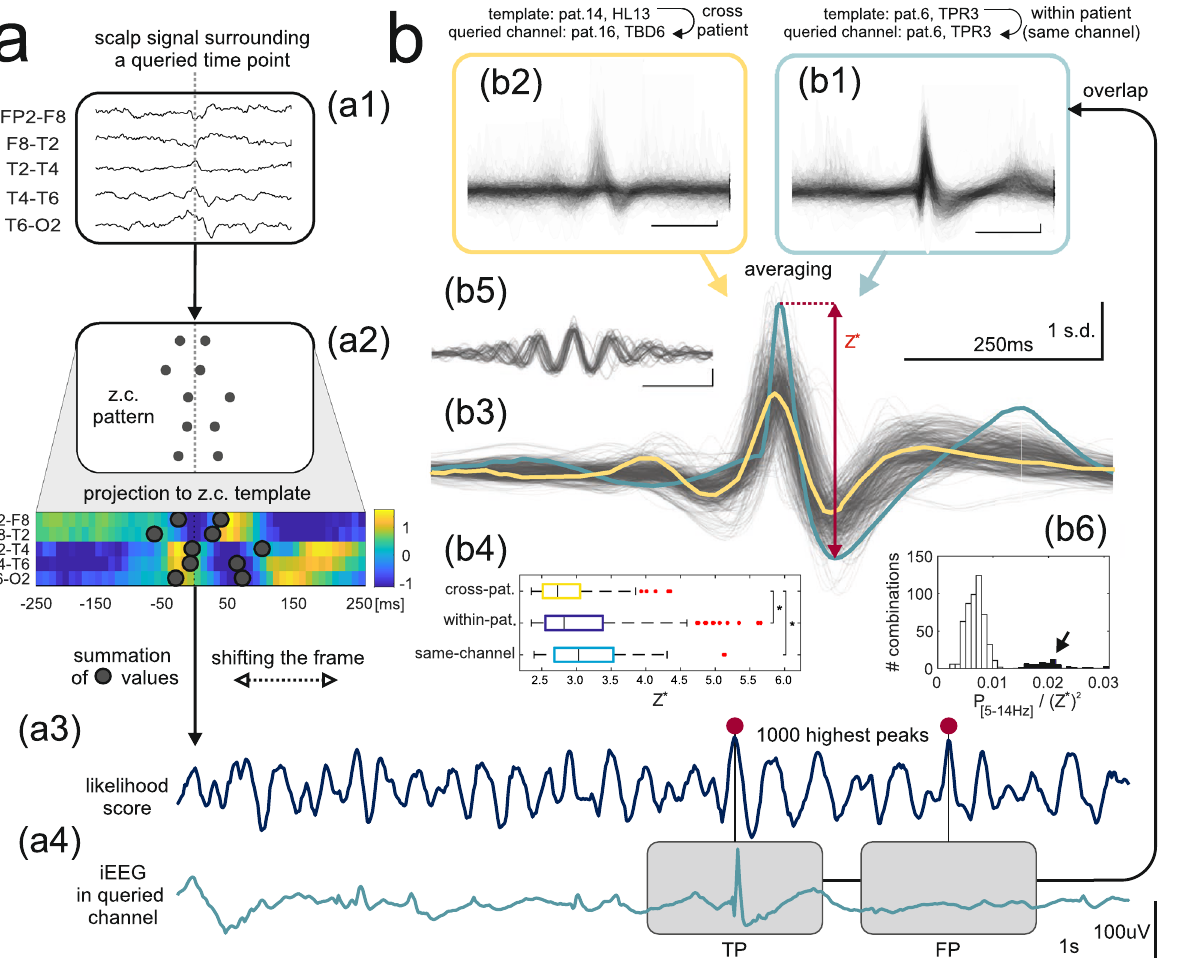
Figure 3. Detection of intracranial IEDs from scalp EEG. ( a ) Application of a template for intracranial IED detection basing on scalp EEG data alone. ( a1 , a2 ) Transformation of an unknown scalp signal ( a1 ) centered around a queried time point (dotted gray line) into a zero-crossing pattern with subsequent ‘projection” of the pattern onto the template ( a2 ) and summation of template values over zero-crossing coordinates to obtain the likelihood score. ( a3 ) Shifting the frame renders the likelihood score a function of time whose peaks are then used as the times of putative intracranial IEDs. ( a4 ) True positive (TP) and false positive (FP) detections are illustrated after referring back to a queried iEEG channel. ( b ) Single-trial detection and iEEG signal averaging. ( b1 , b2 ) Individual iEEG waveforms detected in two template-queried channel combinations show a high degree of overlap. ( b3 ) Consistent spike-like shapes after averaging of the individual waveforms for a subset of combinations (see “Results”). Light blue and yellow correspond to averages of ( b1 , b2 ), respectively. The peak-to- peak amplitude (Z * ) is illustrated as a measure of detection precision. ( b4 ) Comparison of Z * for within-patient, cross-patient, and same channel template-queried channel combinations. ( b5 , b6 ) Detection of theta and alpha rhythms (see “Results”): ( b5 ) Overlap of averaged waveforms. ( b6 ) Clustering of the averaged waveforms, the arrow indicates theta and alpha